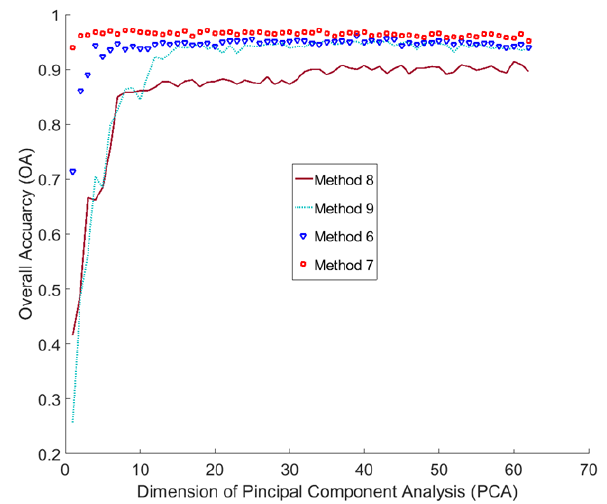
Figure 7. Dimension of PCA and Overall Accuracy (OA) obtained by